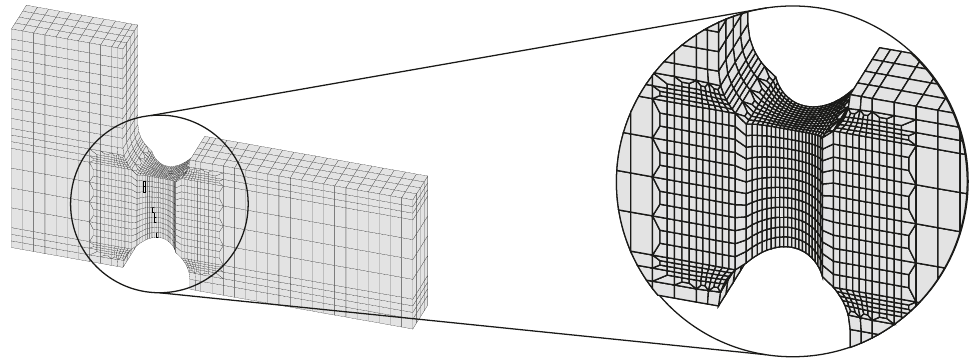
Figure 3. Finite element